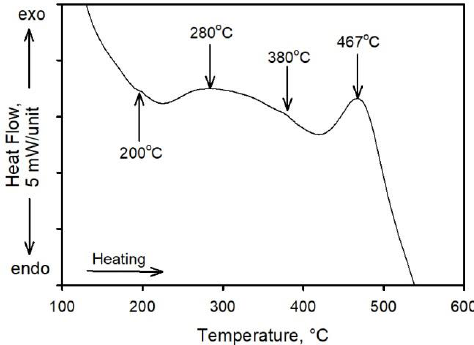
Figure 2. DSC curves of 0.4%C-1.6%Si-1%Cr-0.95%Mo steel with V and Nb obtained at 10 °C/min. The arrows indicate the onset of a reaction and peak temperatures.